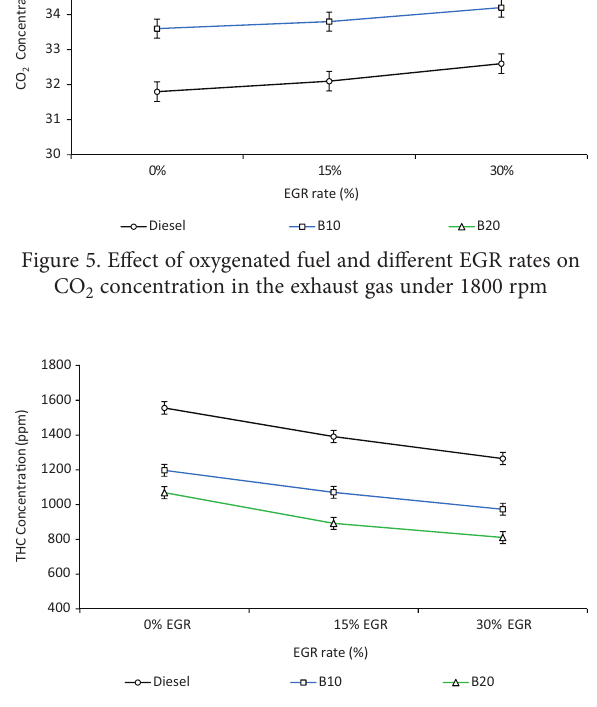
Figure 6. Effect of oxygenated fuel and different EGR rates on THC concentration in the exhaust gas under 1800